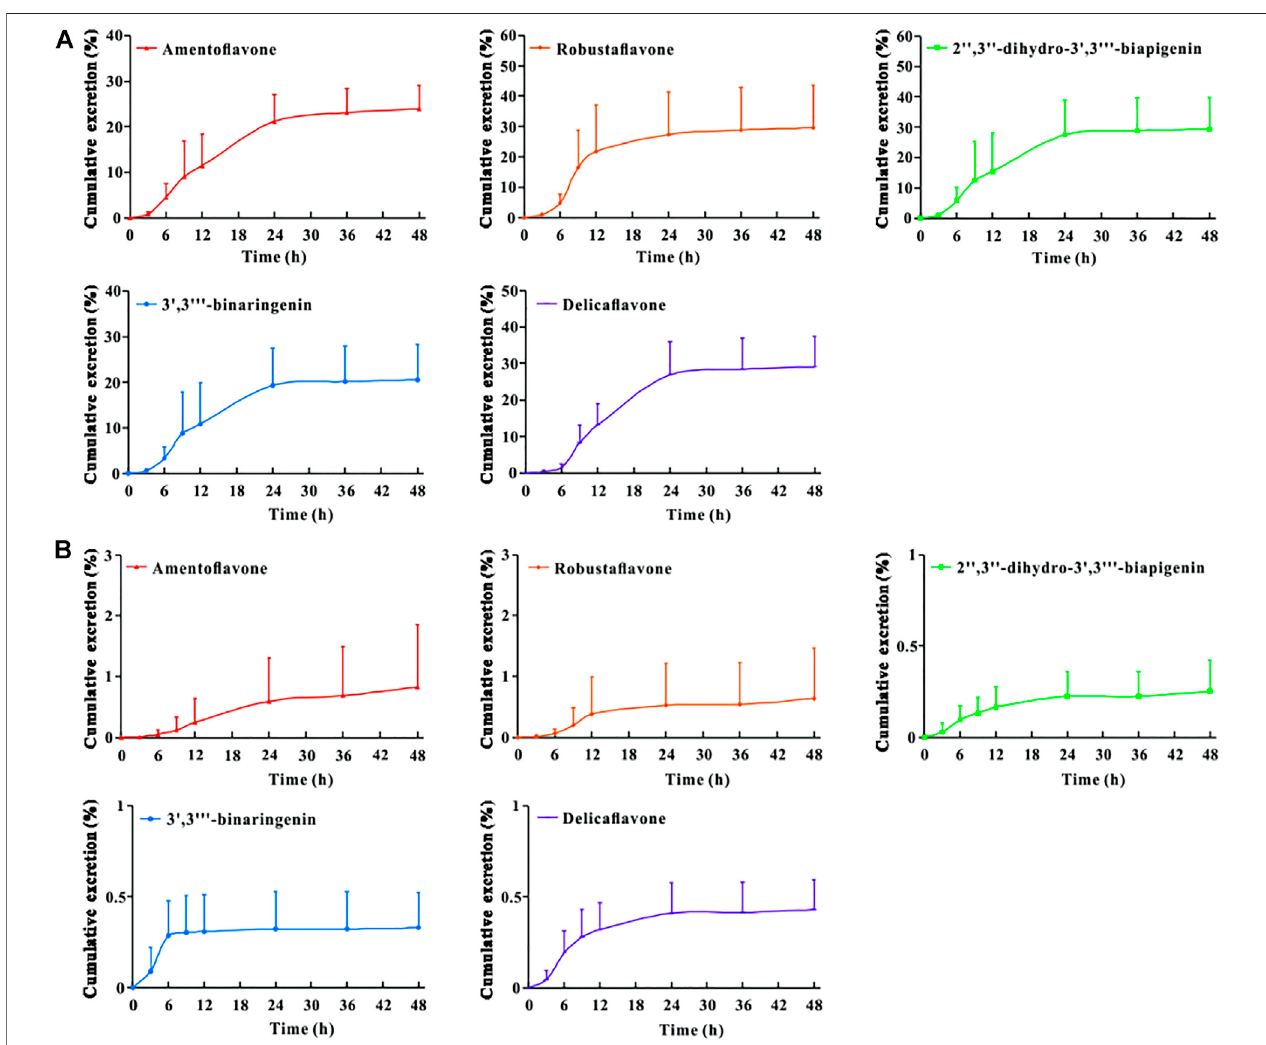
FIGURE 3 | Cumulative excretion-time pro fi les of amento fl avone, robusta fl avone, 2 ″ ,3 ″ -dihydro-3 ′ ,3 ‴ -biapigenin, 3 ′ ,3 ‴ -binaringenin, and delica fl avone in rat feces (A) and urine (B) after oral administration of TBESD at a dose of 600 mg/kg (Mean ± SD, n = 6).